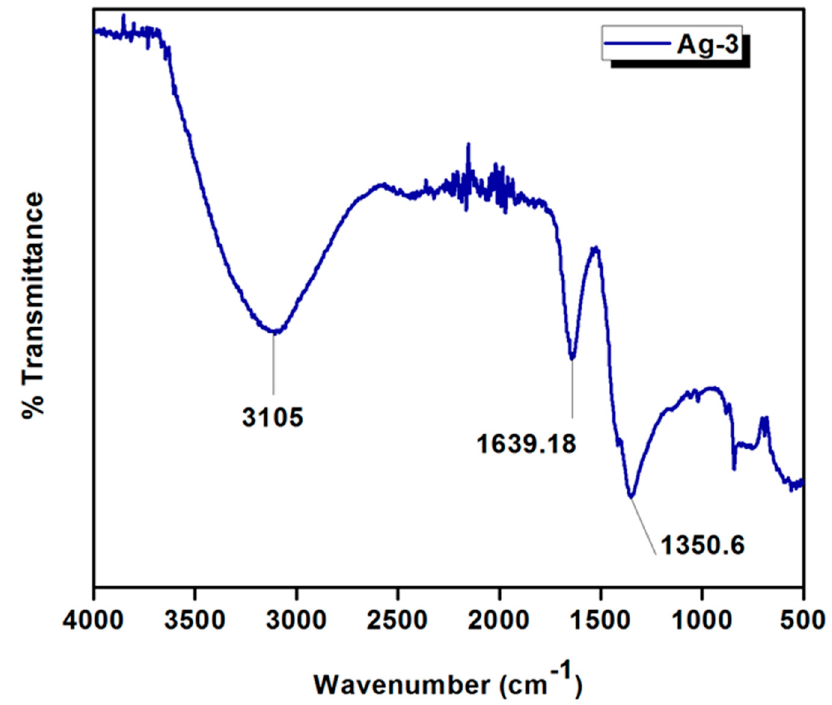
Figure 8. Fourier Transformed Infrared Spectrometry (FTIR) spectrum of conductive film.